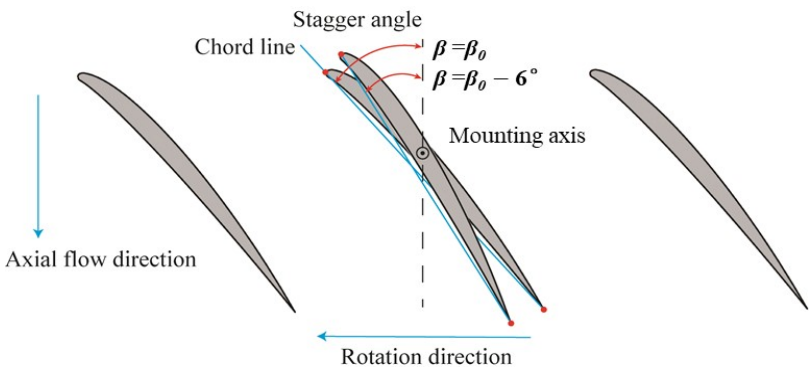
Figure 3. Diagram of the definition of the stagger angle.